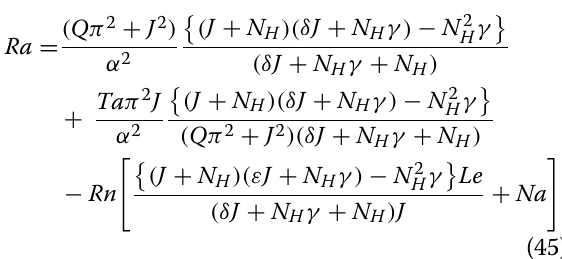
Fig. 9 Comparison of LTNE and LTE model